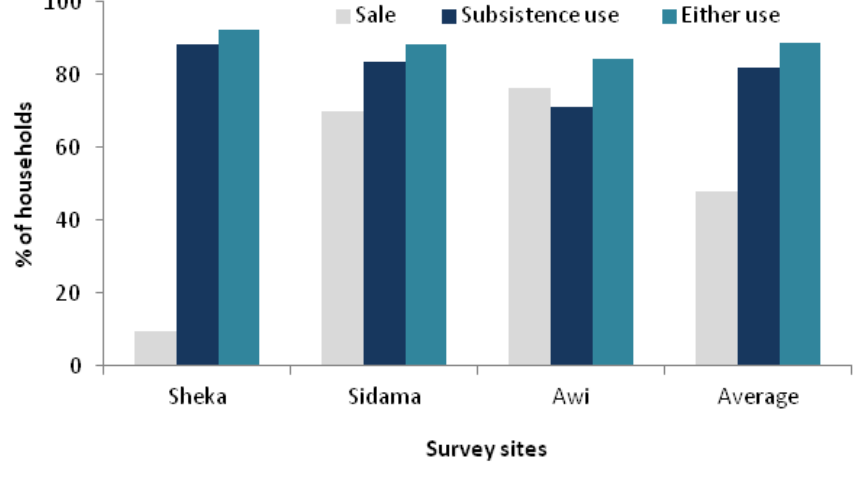
Figure 3. Percentage of annual bamboo utilization by households in the